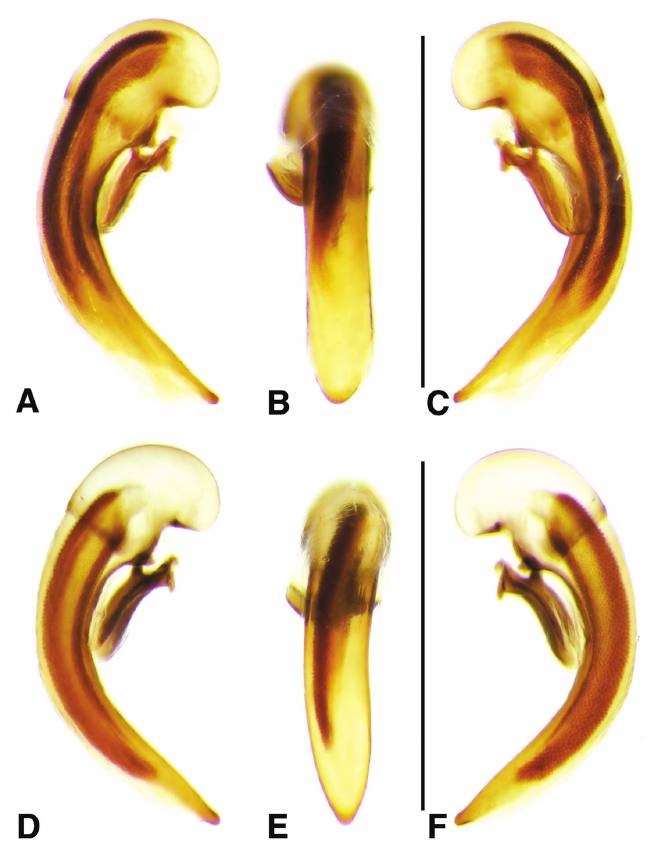
Figure 36. Digital images of male genitalia of Selenophorus nonseriatus species group, in part. A, D right lateral aspect B, E dorsal aspect C, F left lateral aspect A–C S. iviei sp. n. D–F S. nonseriatus Darlington. Scale bars 1